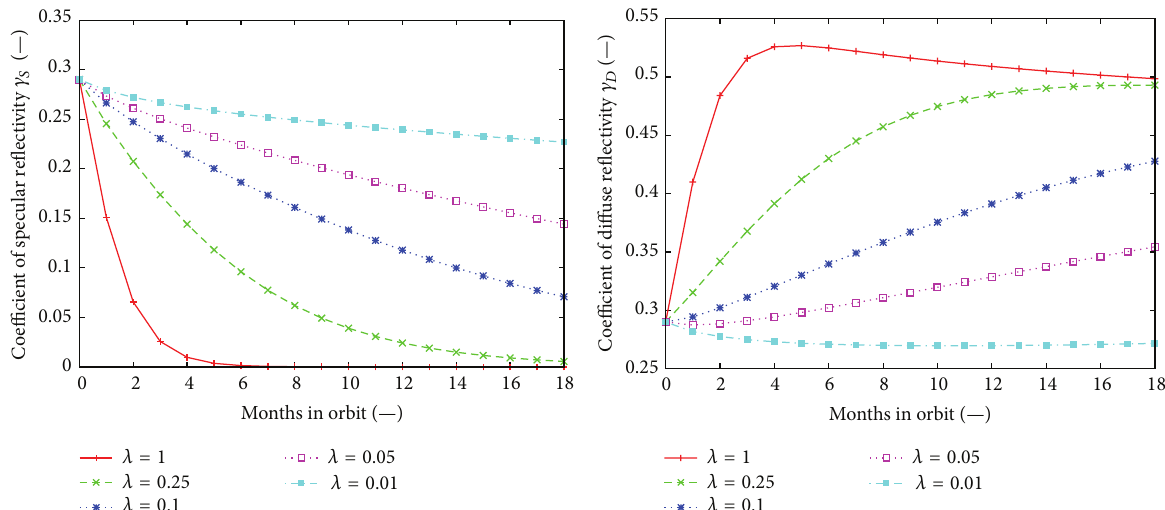
Figure 11: Time evolution of 𝛾 𝑆 and 𝛾 𝐷 for different scaling factors. MLI values considered for starting reflectivities with a 𝜇 𝑆𝐷 of 1.